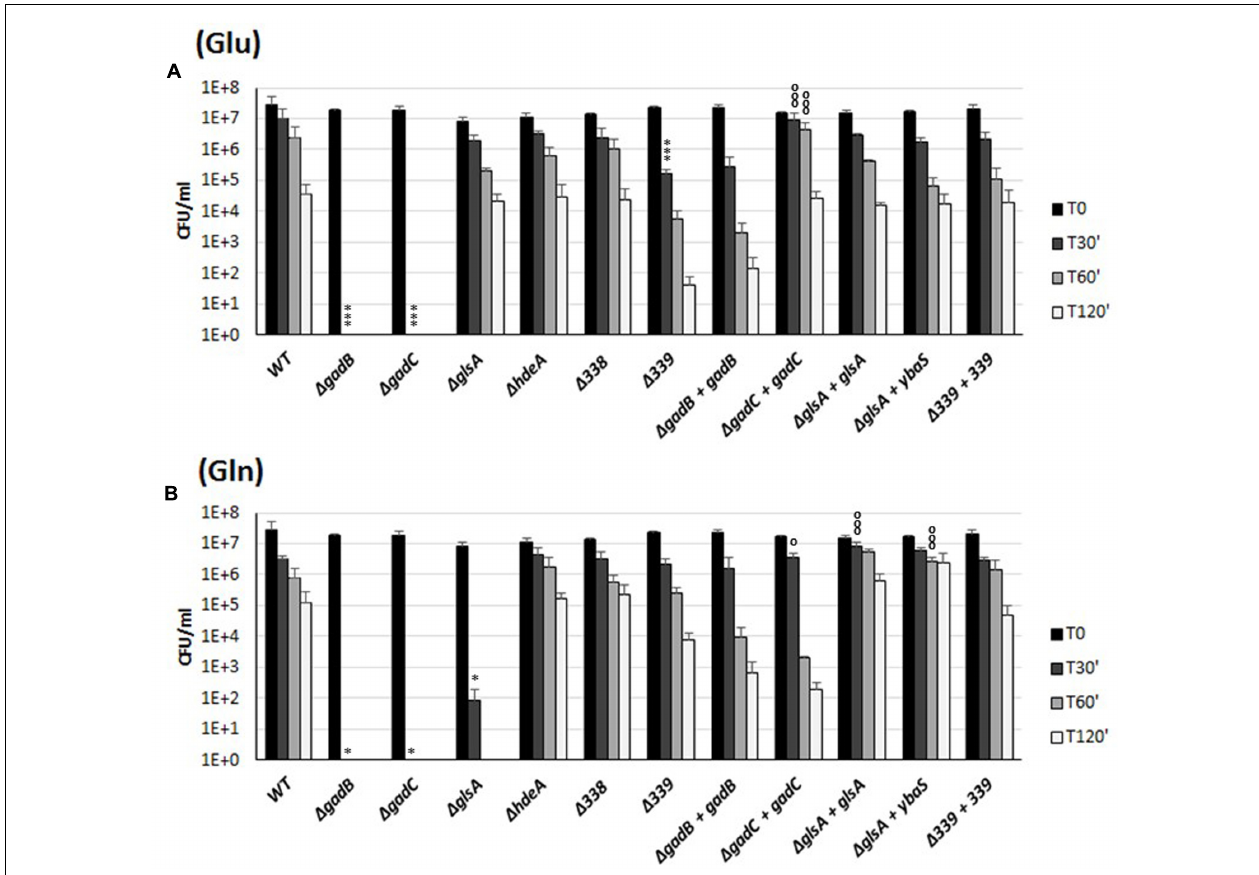
FIGURE 3 | Survival of the wild-type and mutant strains of individual genes of the B. microti CCM4915 gadBC – glsA operon during extreme acid exposure. Bacteria from stationary-phase cultures in TS at pH 7 were harvested and incubated in modified GMM at pH 2.5, supplemented with 3 mM of Glu (A) or Gln (B) . Mutant strains are indicated by “ (cid:49) ” and the designation of the inactivated gene. Complemented mutant strains are designated by “+” followed by the name of the in trans complementing gene. Residual viability following the acid shock was expressed as CFU/ml on a log10-scale at each time-point (T30, T60, and T120 min) and compared to unchallenged bacteria present at time T0 (GMM, pH 7.0). No viable bacteria were detected at the same time-points in the absence of Glu or Gln (data not shown). The data represent the mean (SD) of three independent experiments. A two-way ANOVA with a Bonferroni post-test statistical analysis was performed between wild-type and each mutant strain (significance ∗ P < 0.05, ∗∗ P < 0.01, ∗∗∗ P < 0.001) and between each mutant strain and the corresponding complemented strain (significance ◦ P < 0.05, ◦◦ P < 0.01, ◦◦◦ P <